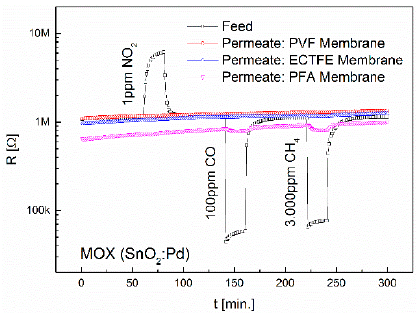
Figure 7. Separation properties of PVF, ECTFE and PFA upon exposure to 100 ppm CO, 3000 ppm CH 4 and 1 ppm NO 2 . The diameter of the membranes is 6.4 mm.